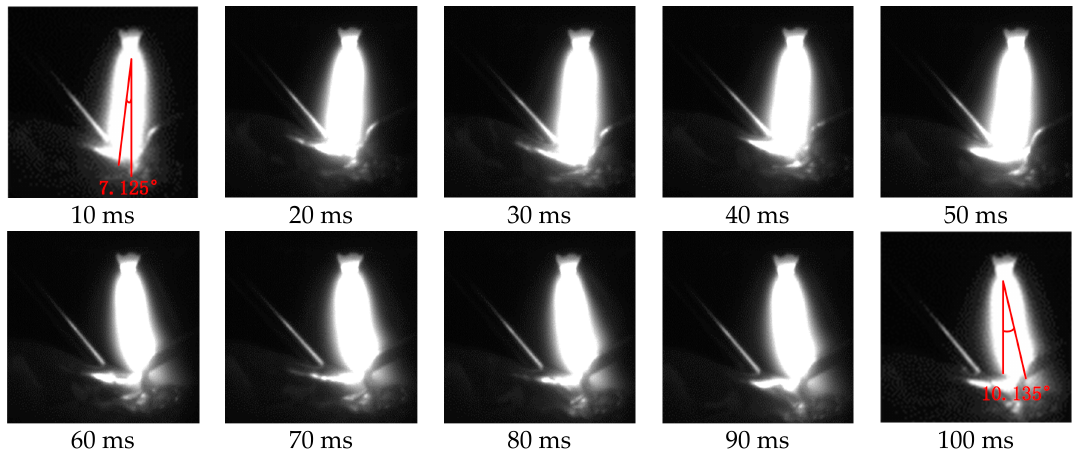
Figure 7. Arc swing in the model of “bridge transfer + bridge transfer”.